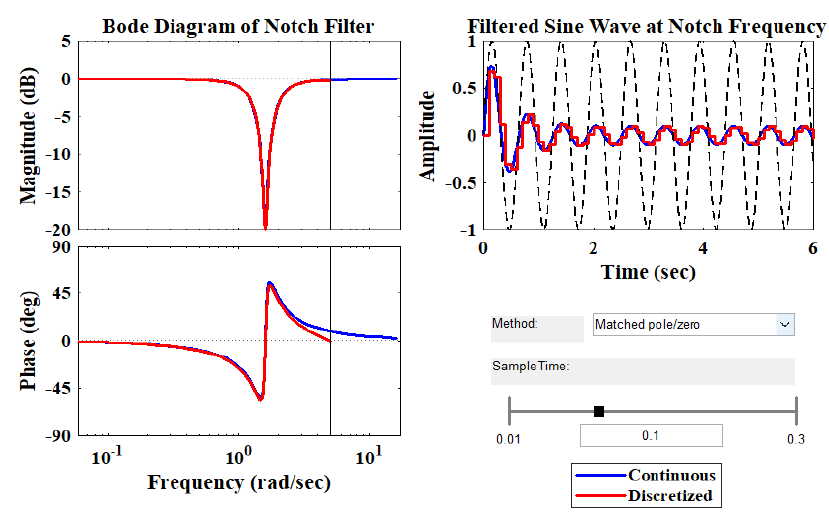
Figure A2. Bode plot and filter sine wave result at the notch frequency.